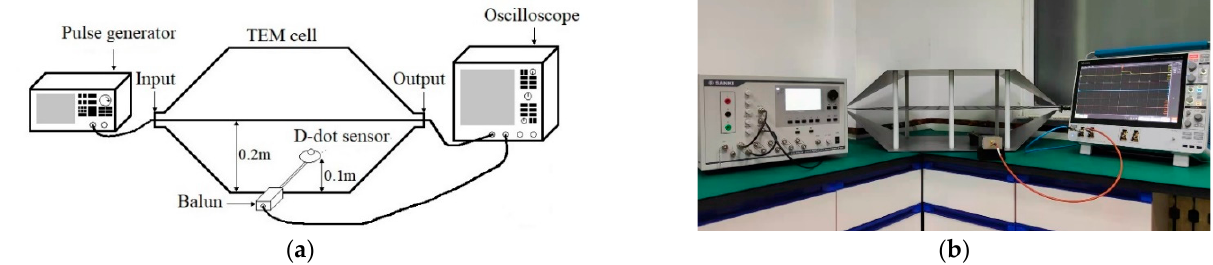
Figure 5. Calibration setup of the D-dot measurement system: ( a ) schematic diagram; ( b ) physical photo.